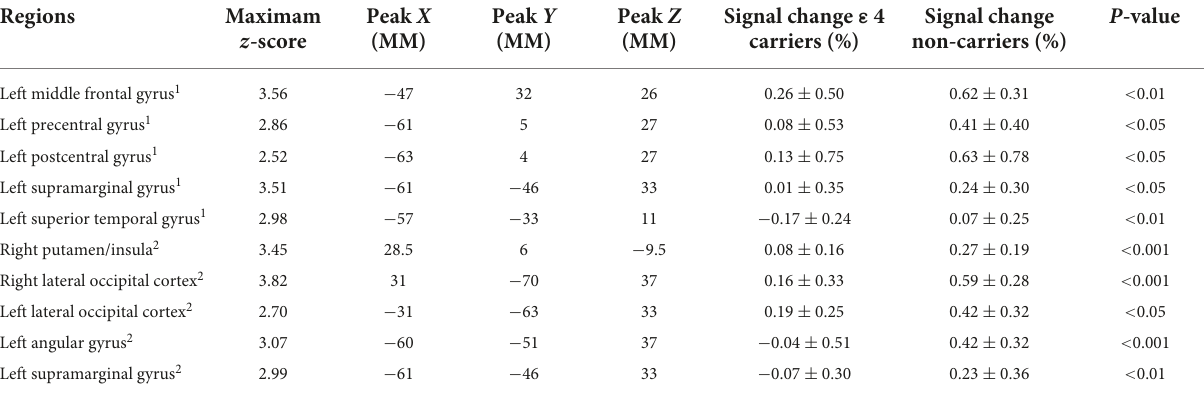
TABLE 2 Results of the whole-brain analysis of the n-back data modeling APOE genotype group differences in activation during the n-back. Regions